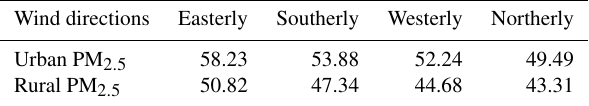
Table 1. Average PM 2 . 5 concentrations (unit: µgm − 3 ) in urban and rural areas under different prevalent wind